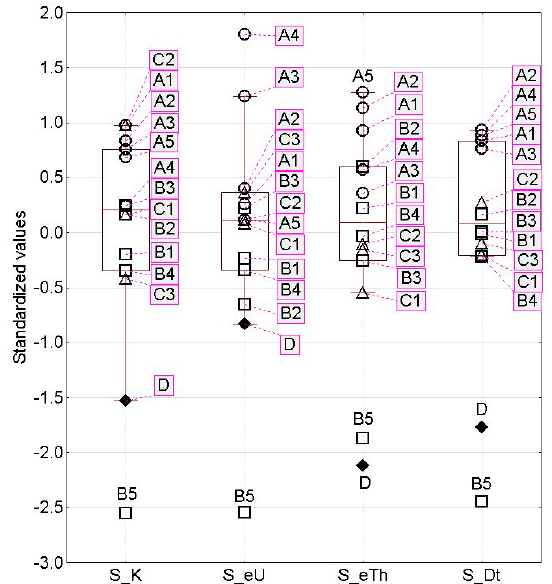
Figure 3. Box-and-whisker plot (with discrimination of individual values) of standardized estimations from portable gamma spectrometry.